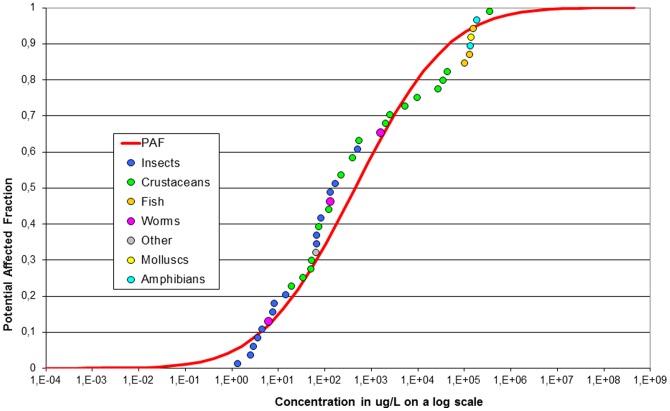
The Species Sensitivity Distribution of imidacloprid based on acute toxicity data.The data consist of 7 different taxomonic groups and 41 species. EPA database downloaded at Oct 23th 2013.